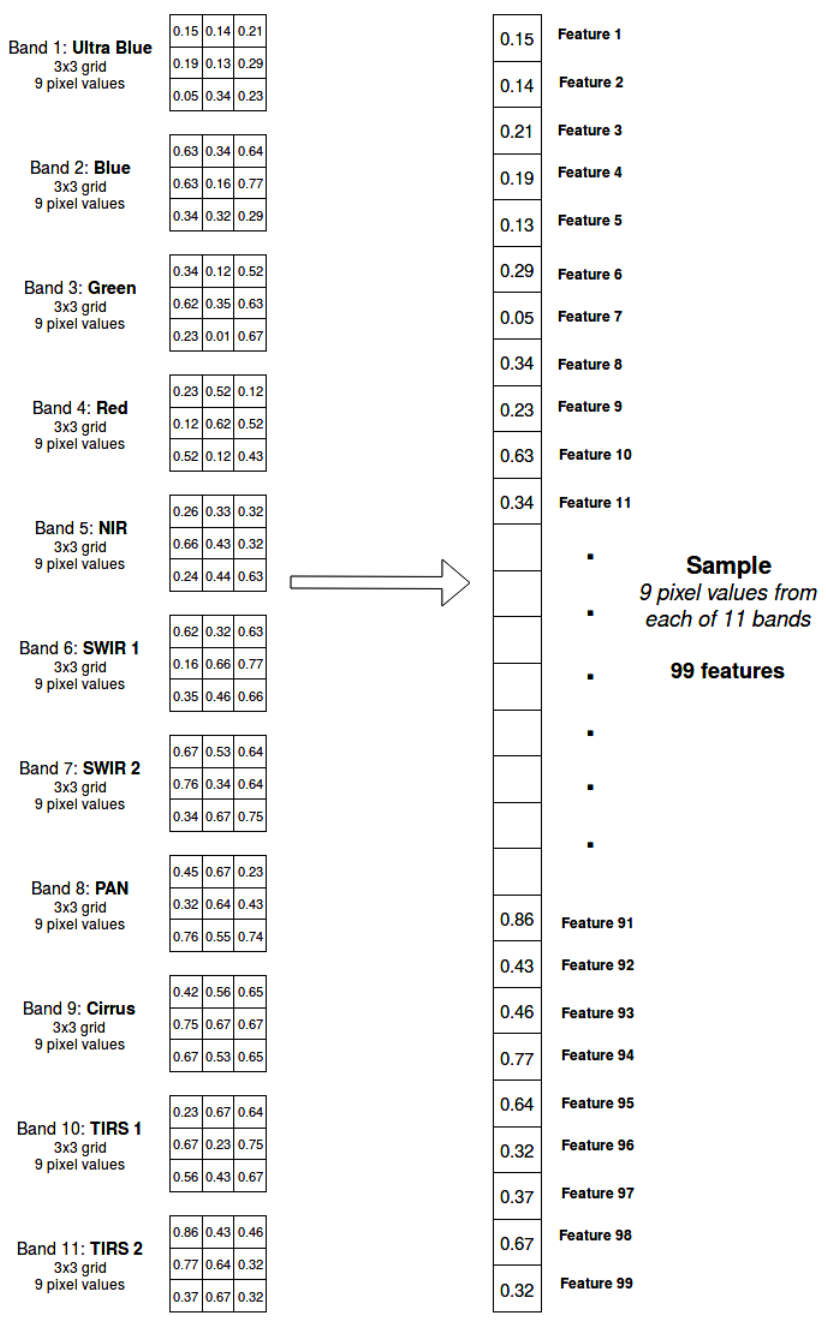
Fig. 3. Example of conversion of satellite image grid to training and testing